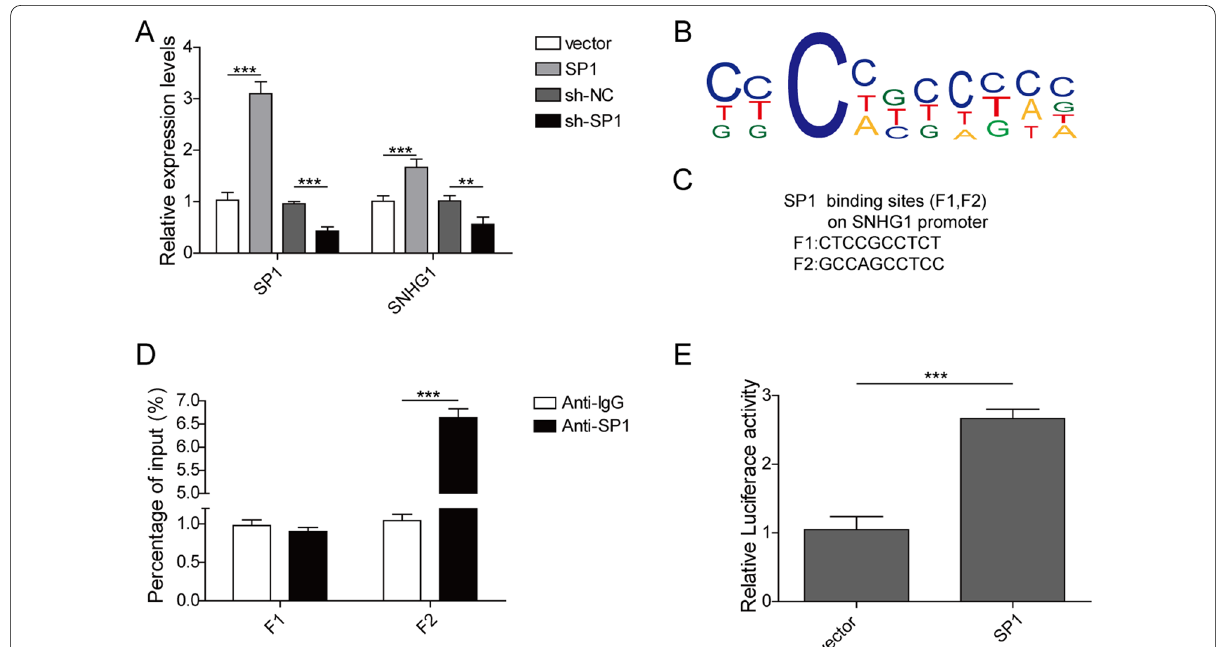
Fig. 8 LncRNA SNHG1 was activated by SP1. A The BMSCs were transfected with SP1 vector, sh‑SP1 or their negative control, the levels of SP1 and lncRNA SNHG1 were measured using qPCR. B Predicted positions of putative SP1 binding motif in SNHG1 promoter using JASPAR. C Schematic presentation of SP1 binding sites in the promoter region of SNHG1. D ChIP‑qPCR analysis showed the SP1 occupancy of SNHG1 promoter. E Dual luciferase reporter assay was conducted to verify SP1 binding sites on SNHG1 promoter region around F2. ** P < 0.01, *** P <